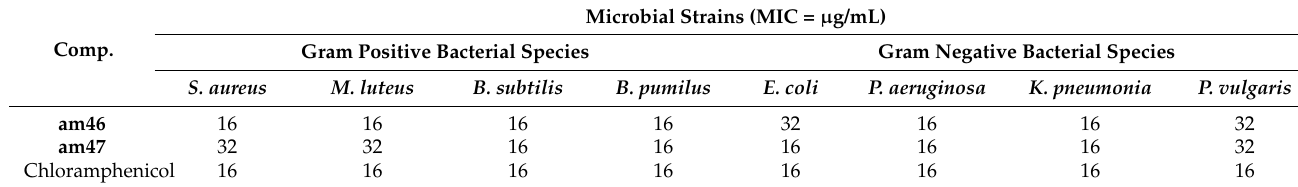
Table 20. Antibacterial activity (MIC = µ g/mL) of the compounds (am46 – am47 ).